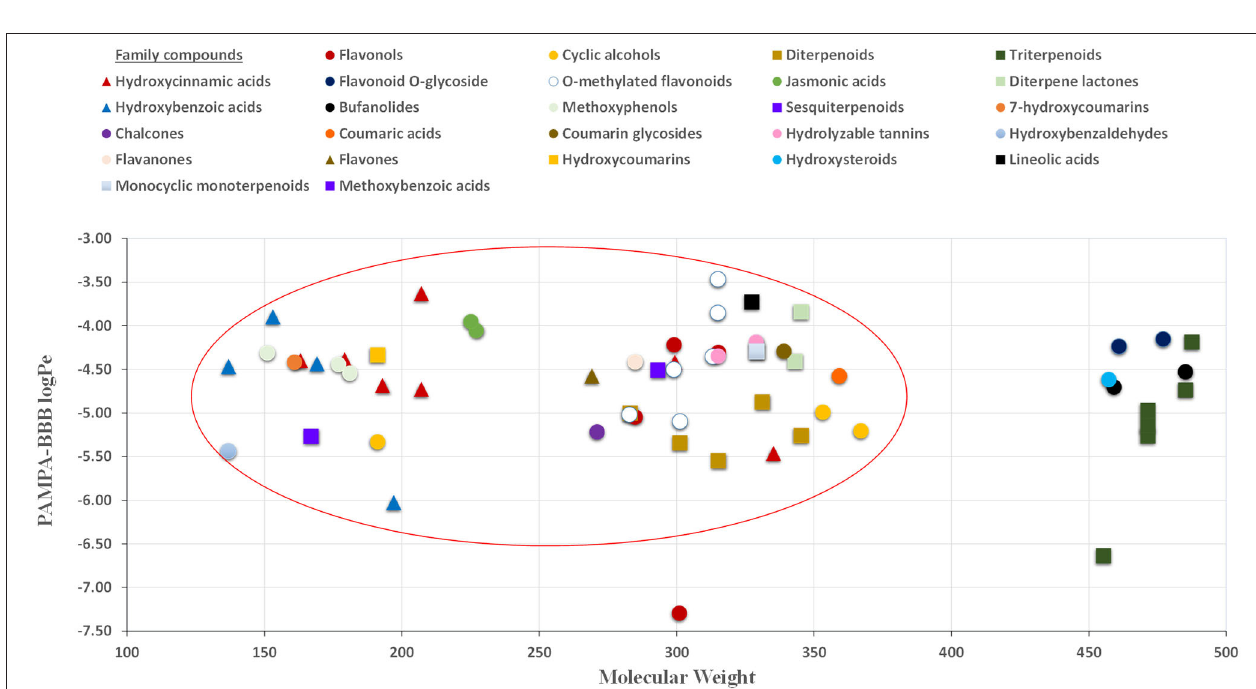
FIGURE 1 | UHPLC-Q-TOF-MS/MS extracted ion chromatograms of representative bioactive compounds (kaempferol, isoquercitrin, ellagic acid, and ethyl caffeate) from T33 (Cyphomandra betacea, tamarillo PLE extract), ASFE (Robinia pseudoacacia, acacia SFE extract), and LPLE (Nothofagus pumilio, lenga PLE extract) extracts detected in the donor (blue) and acceptor plates (dark) of the PAMPA-BBB model.